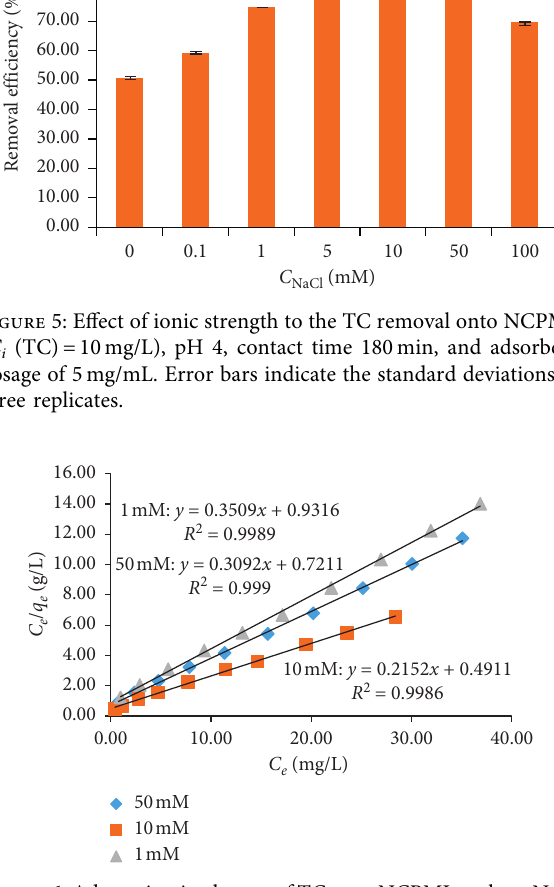
Figure 6: Adsorption isotherms of TC onto NCPML at three NaCl concentrations fitted by the Langmuir model.